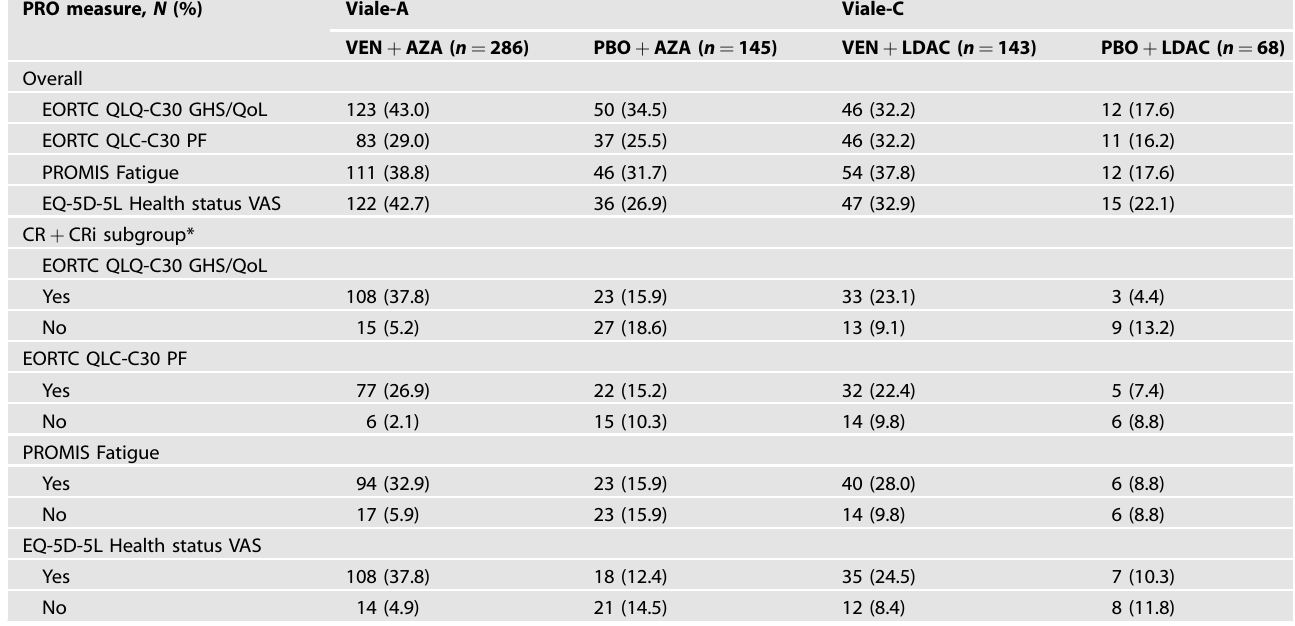
Table 3. Proportion of patients with improvements at any time post-baseline in PROs overall and by patients achieving CR +